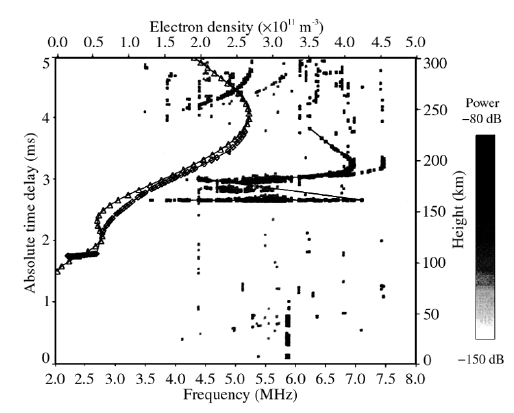
Fig. 6. An oblique ionogram and bottomside pro- file of electron density from IRIS observations in U.K., together with a complete profile at the mid- point obtained from a corresponding tomographic image. From Heaton et al. (2001), reproduced by permission of the American Geophysical